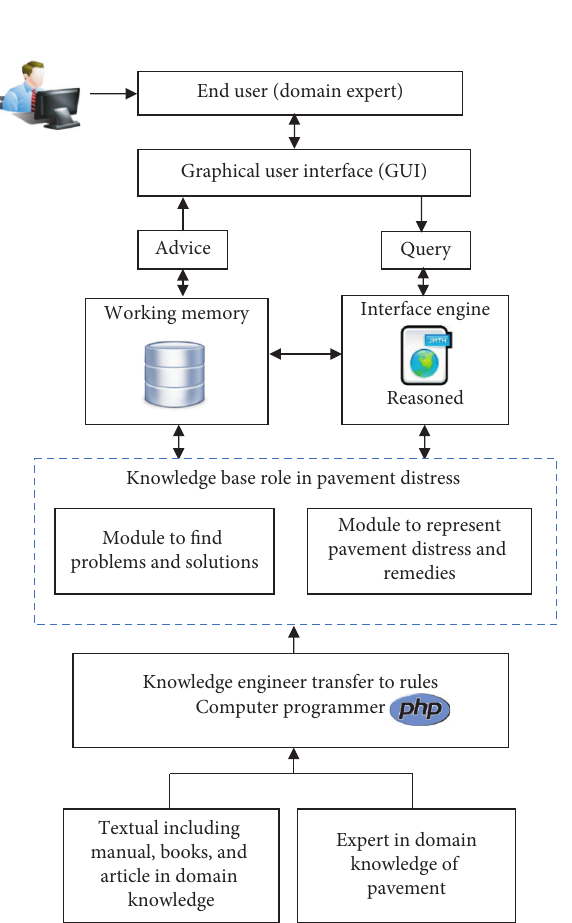
Figure 2: ESTAMPSYS structure and relationship among the parts of the primary system.